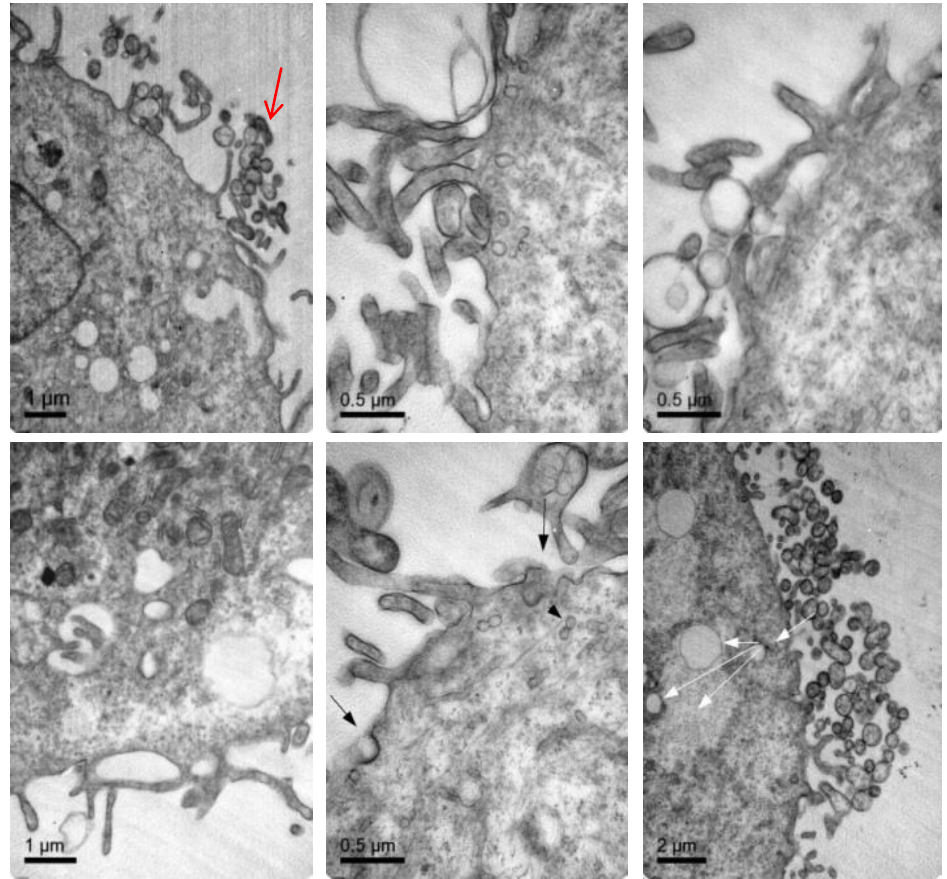
Figure 7. TEM images illustrating elosulfase alfa-loaded NLC internalized into TC28a2 chondrocytes during co-incubation.